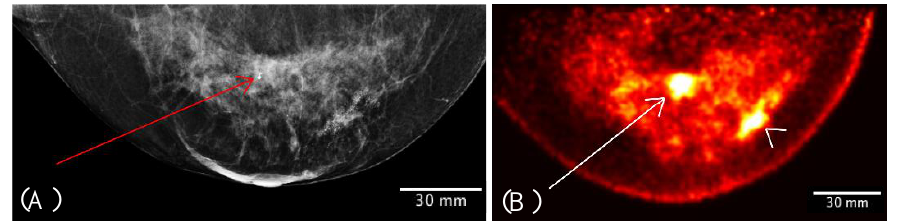
Figure 10. A 56-year-old female with invasive ductal carcinoma and intermediate-grade DCIS. Digital mammography of right breast ( A ) and right breast Radialis PET image with 37 MBq 18 F-FDG injection ( B ) both in the same projection (CC view) are presented for comparison between these two imaging modalities. Cancers are demonstrated by the arrows ( A , B ) and arrowhead ( B ). The second cancer (arrowhead) is visualized only by Radialis PET ( B ).